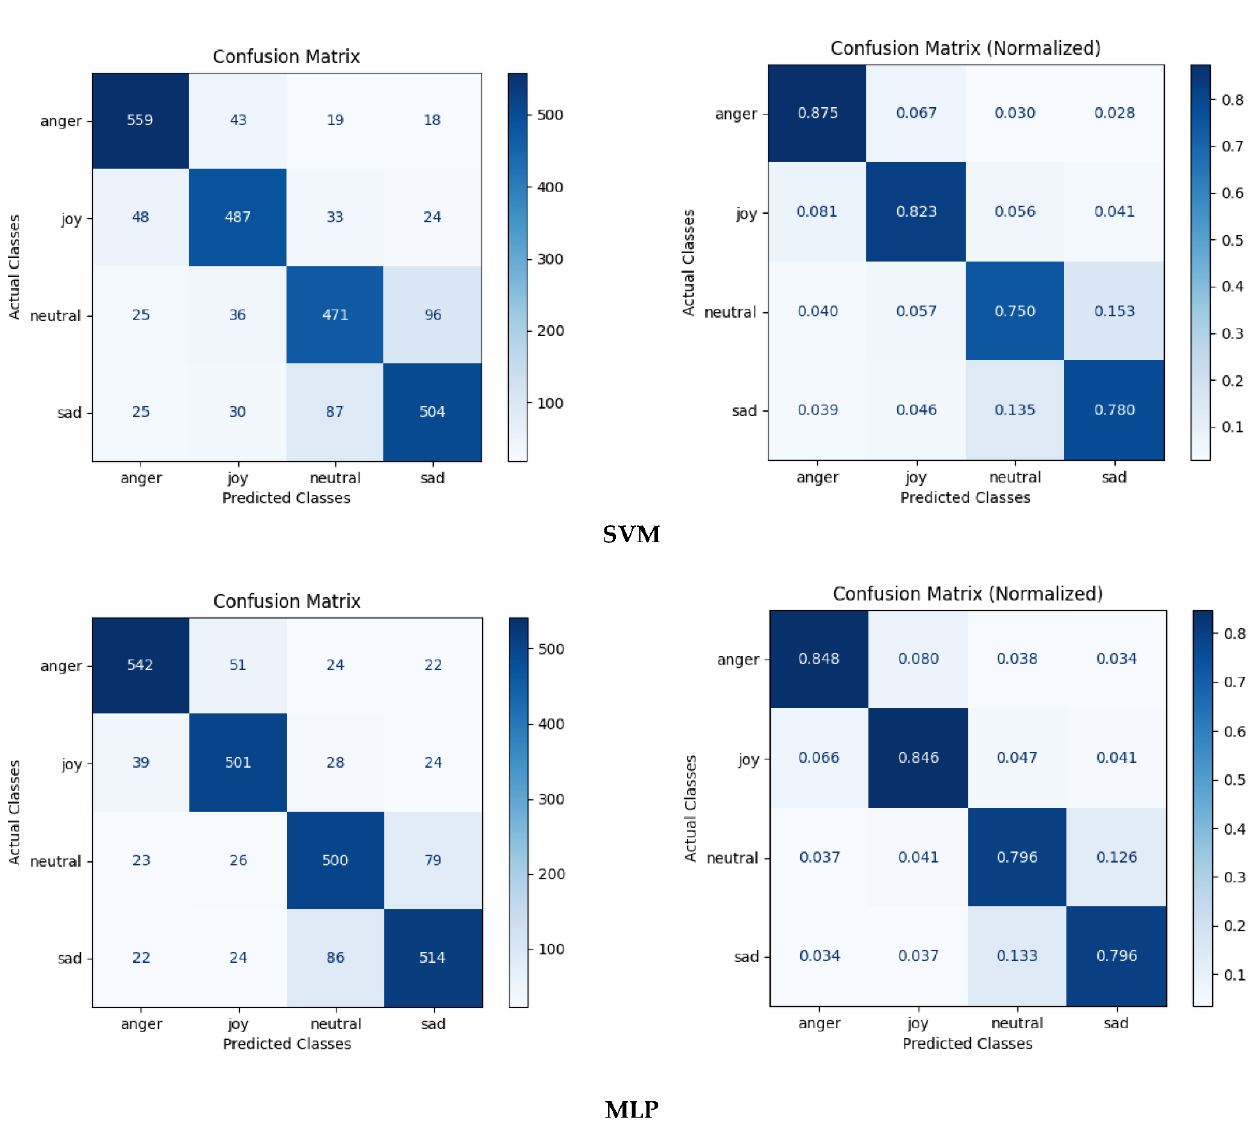
Table 3. Average scores in multi-class classifications, eGeMAPS feature set.